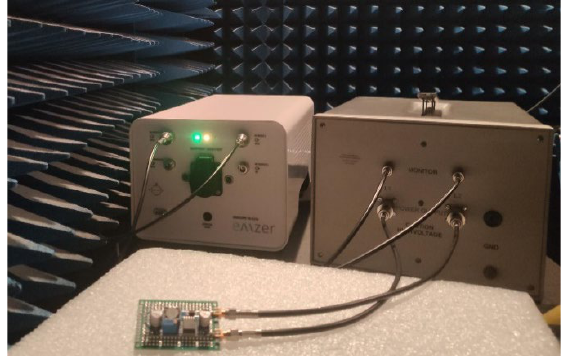
Figure 13. CE measurement setup, which contains a EUT (front row), an EMSCOPE (a two-port EMI receiver, background, left side), and a two-port LISN (background, right side).